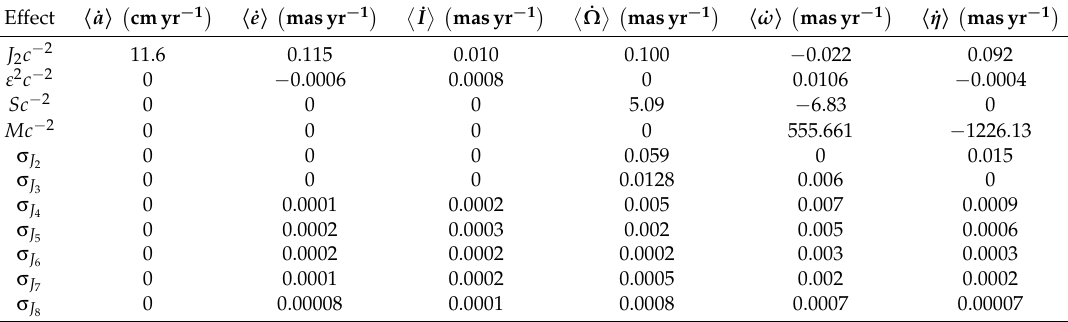
(cid:10) ˙ (cid:11) (cid:10) ˙ Ω (cid:11) I , , (cid:104) ˙ ω (cid:105) , (cid:104) ˙ η (cid:105) .